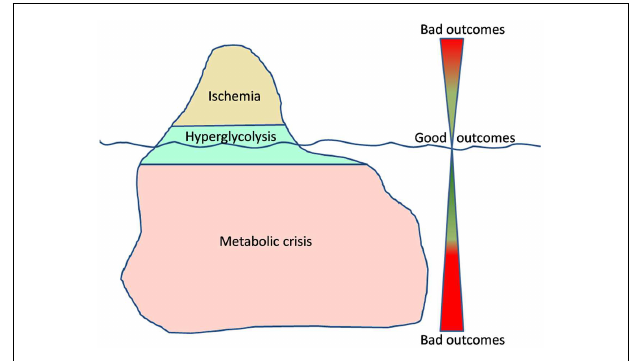
FIGURE 1 |The iceberg of metabolic disturbances associated with a high lactate/pyruvate ratio